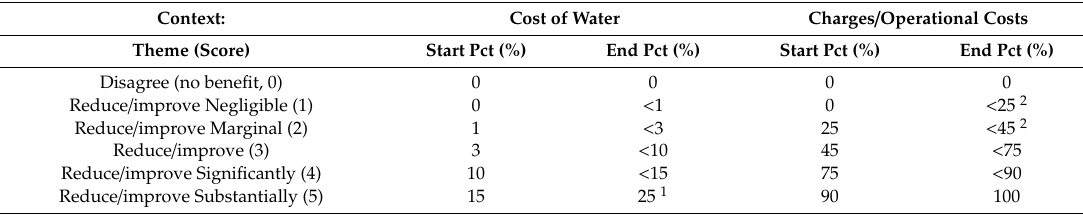
Table 6. Percentage benefit value ranges for themes by